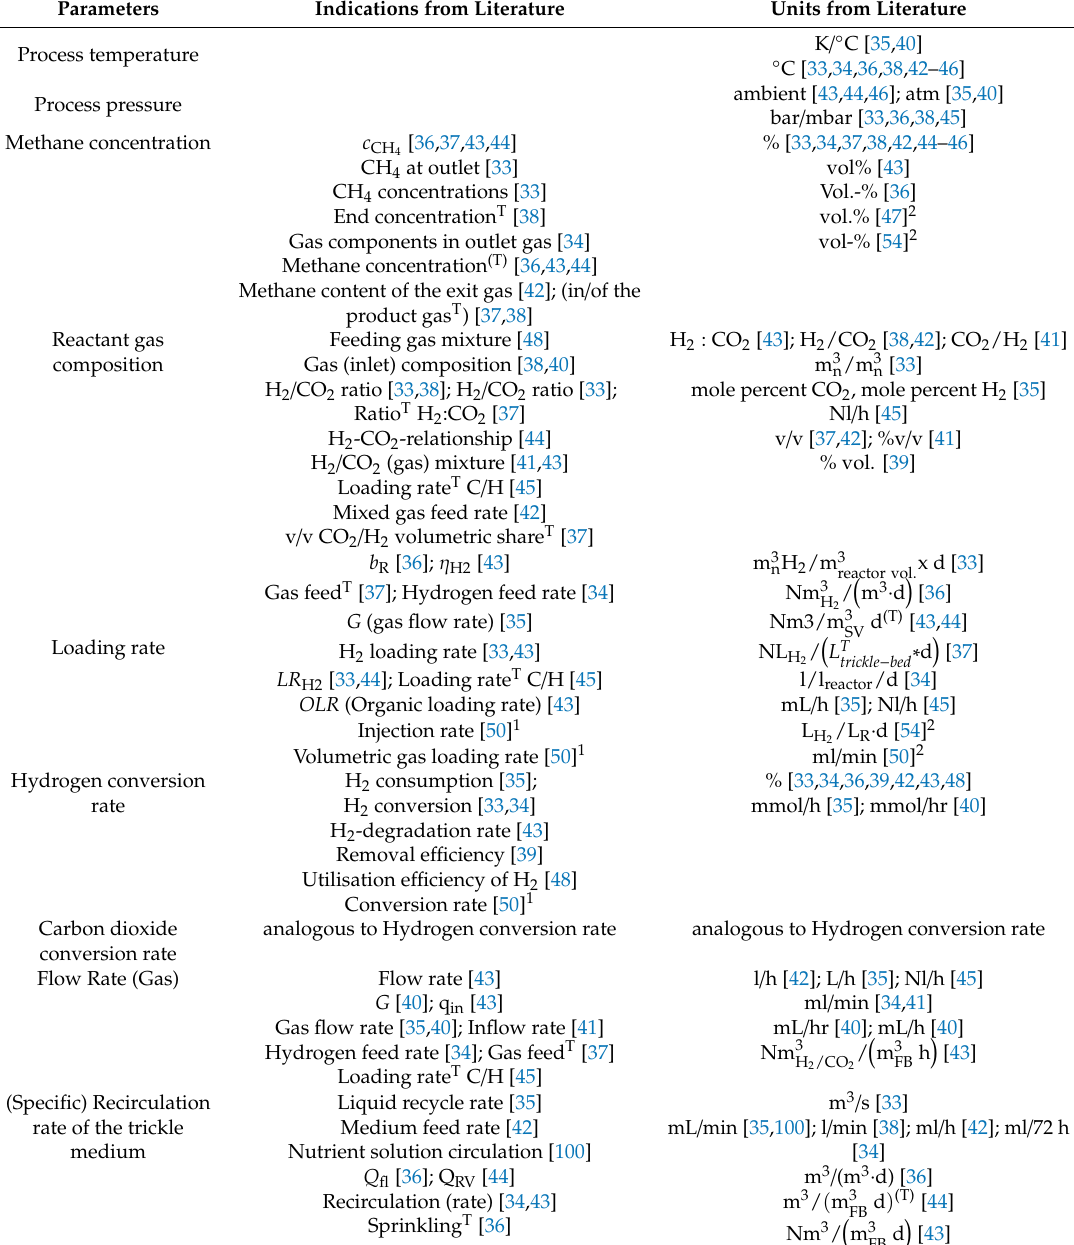
Table A1. Variety in indications and units in current literature on CO 2 -methanation in trickle-bed reactors (extension of Table 1). Minor di ff erences in spelling or case sensitivities reflect inaccuracies of indications and units in